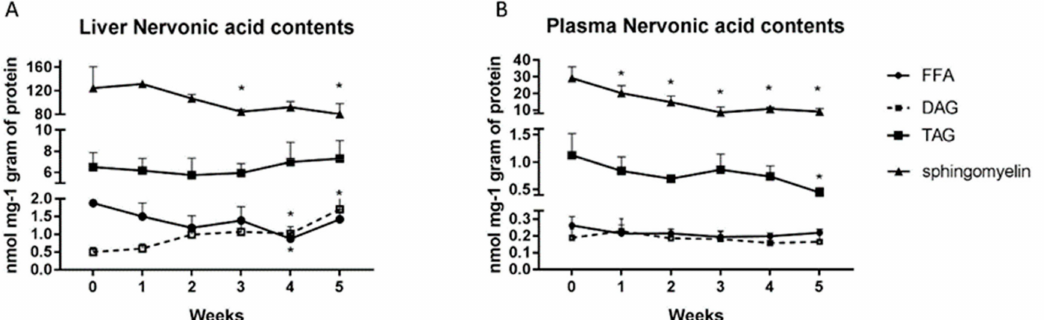
Figure 5. Content of nervonic acid in free fatty acids, diacylglycerols, triacylglycerols and sphingomyelin fraction in the liver homogenates ( A ) and plasma ( B ) from control group (0 week) and HFD group at the end of each experimental week (1, 2, 3, 4 and 5). The nervonic acid content in particular fatty acid fraction was measured by GLC method. The data are expressed as the mean ± S.D. and are based on six independent determinations ( n = 6). * p < 0.05 significant di ff erence vs control group (0